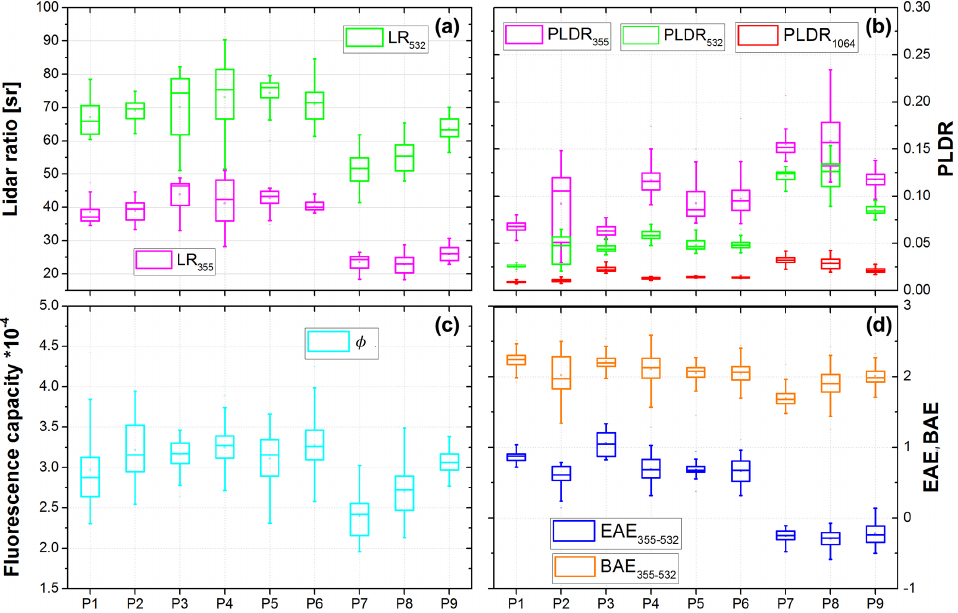
Figure 5. Box plots of the variabilities of BBA intensive parameters during the smoke episodes in September 2020. P1, P2, ..., P9 refer to the time intervals defined in Table 1. Only nighttime observations are considered in this analysis. The measurements in the time intervals are averaged. The lower and upper edges of the box represent, respectively, the first and third quartiles of data. The lower and upper range bars represent, respectively, the minimum and maximum. The dot and bar in the box indicate the mean value and the median value, respectively. (a) Lidar ratios and (b) PLDRs. The colors of the plots represent the different wavelengths (magenta: 355nm; green: 532nm; red: 1064nm).